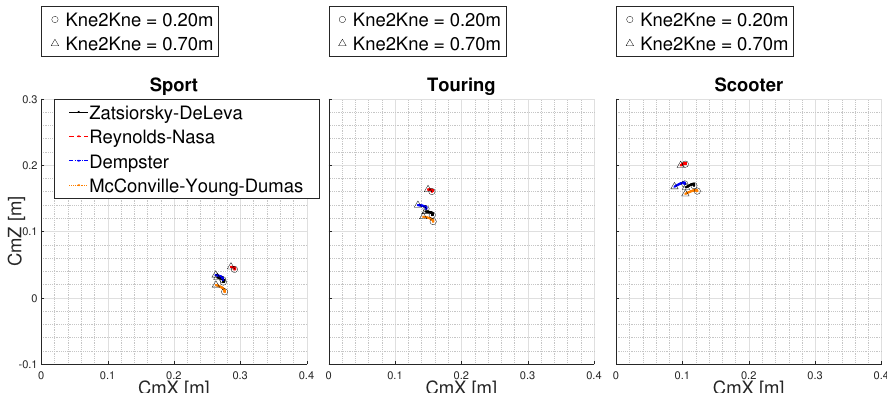
Figure 4. Position of the center of mass as a function of knee